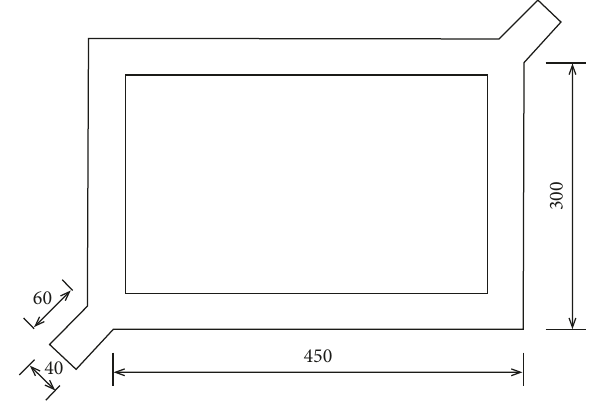
Figure 1: Specimen mould (all dimensions are in mm).